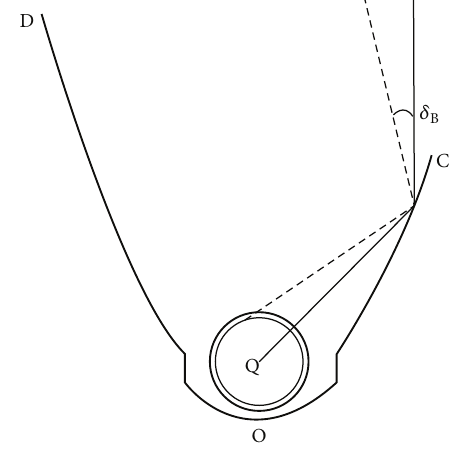
Figure 2: Illustrated diagram of tracking error.